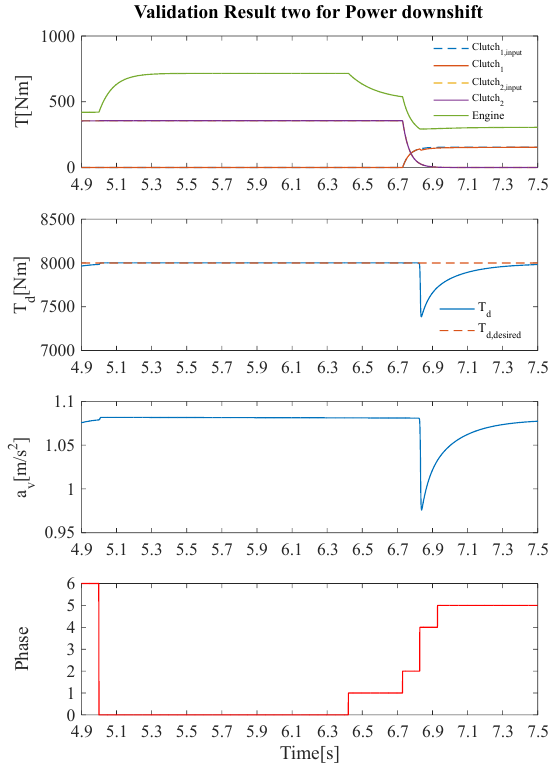
Figure 8. Control variables during the downshifting